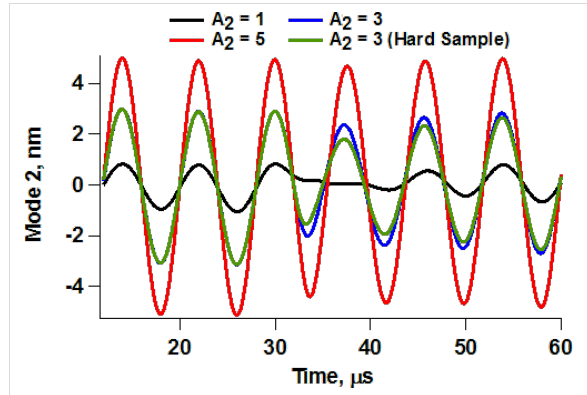
Figure 4: Second eigenmode response for different second mode free amplitude values for the same conditions as the simulations in Figure 3, and for a stiffer sample with K o = 7 N/m and K inf = 7 N/m (green trace), which causes greater perturbation for a given